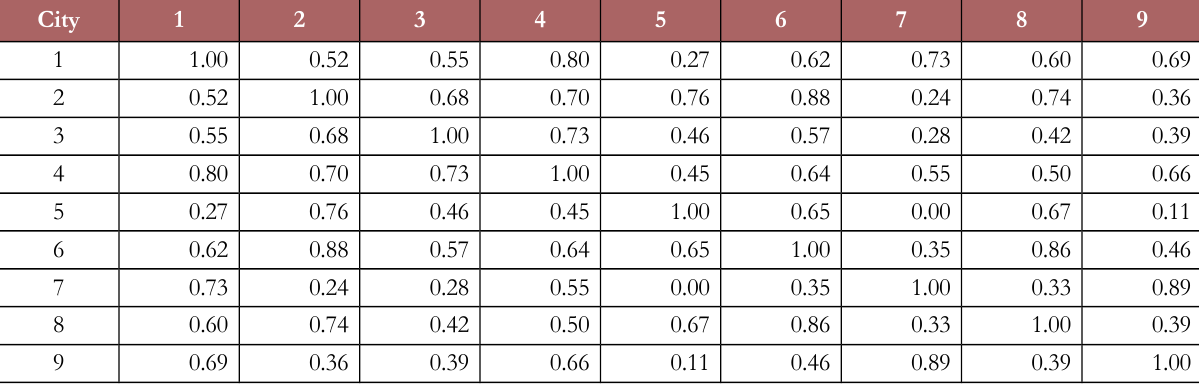
Table 3. RD matrix for the hypothetical